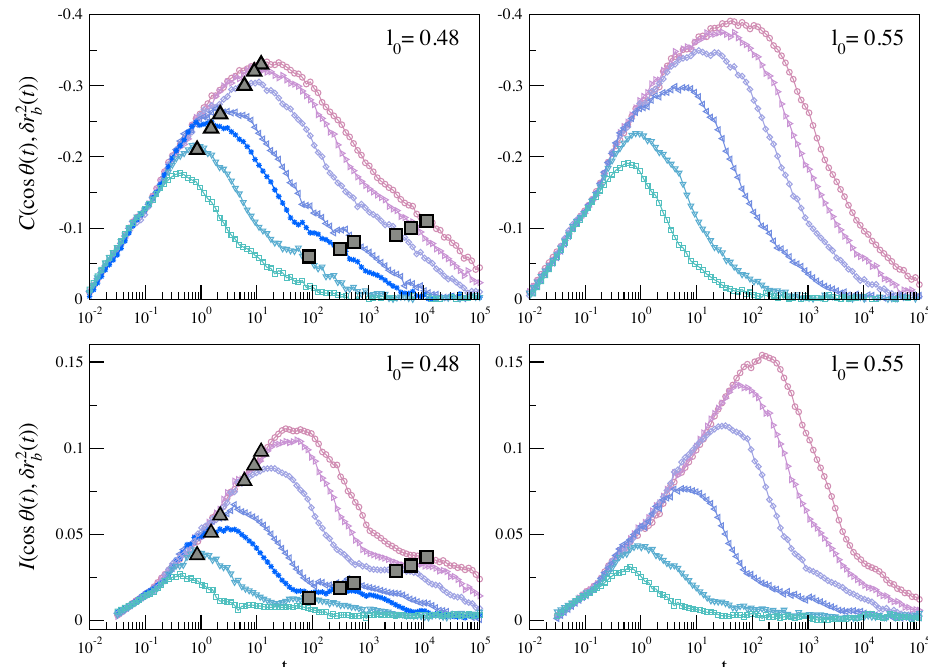
Figure 14. Time dependence of the equal-time correlation between the reorientation and the square displacement of a given bond in a time interval t according to Pearson ( top ) and MI ( bottom ) for the systems with ( l 0 = 0.48 ) and without ( l 0 = 0.55) JG relaxation. The dots indicate the position of the NGP local maxima at the JG (triangle) and structural (square) relaxation time scales [26]. Color codes as in Figure